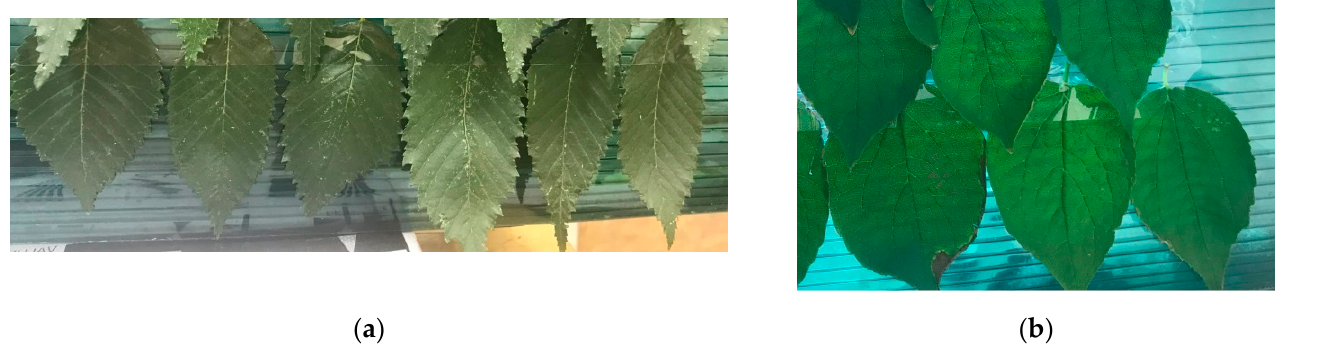
Figure 12. Leaves of ( a ) elm and ( b ) linden were used in the